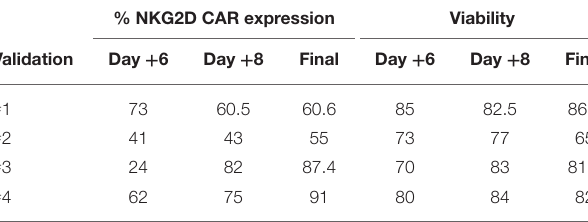
TABLE 2 | Data from transduction efficiency and viability.